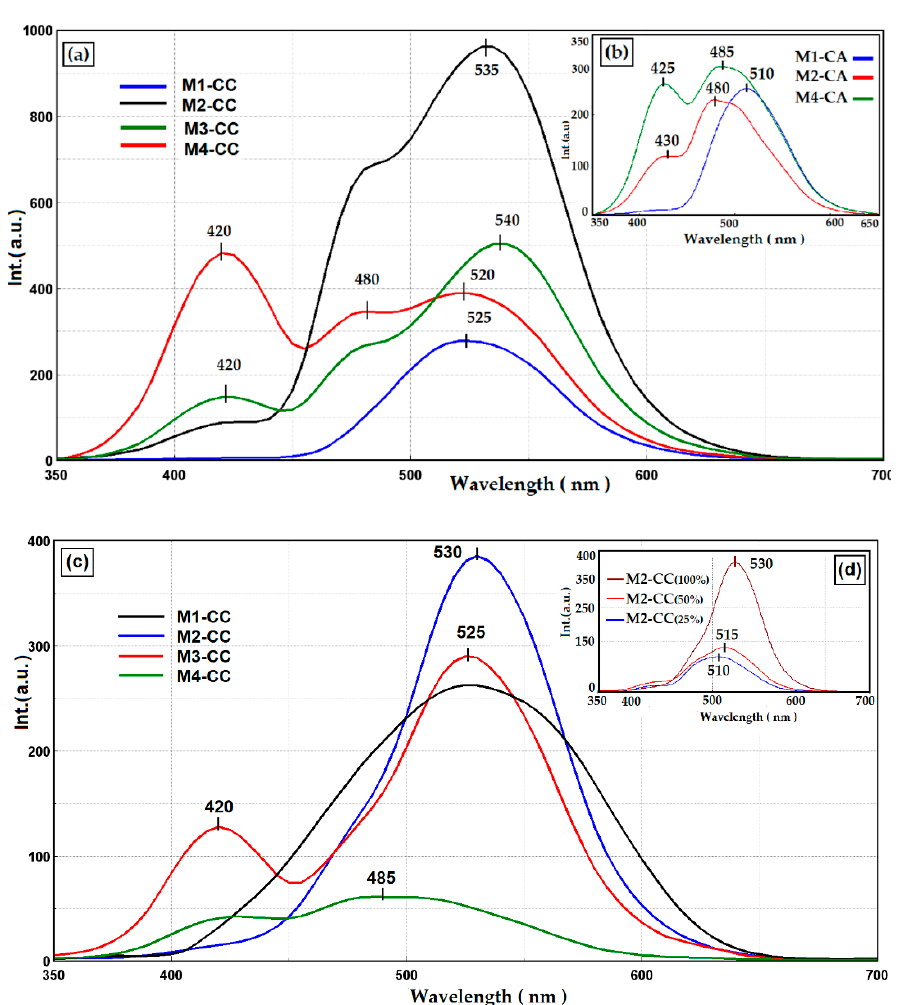
Figure 7. Fluorescence emission spectra of ( a ) hybrid films with curcumin and ( b ) curcumin deriva- tives deposited on PET, ( c ) hybrids from different matrices with curcumin, and ( d ) with different curcumin loadings, deposited on